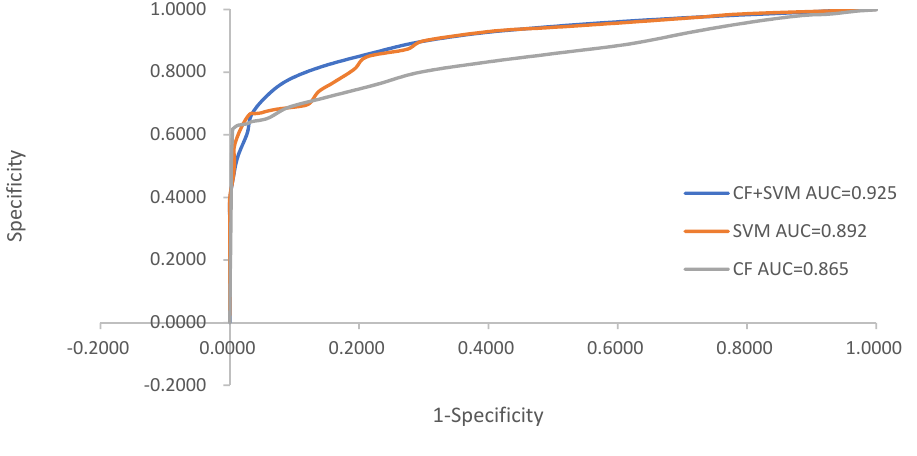
Figure 8. ROC Figure 8. ROC curve.